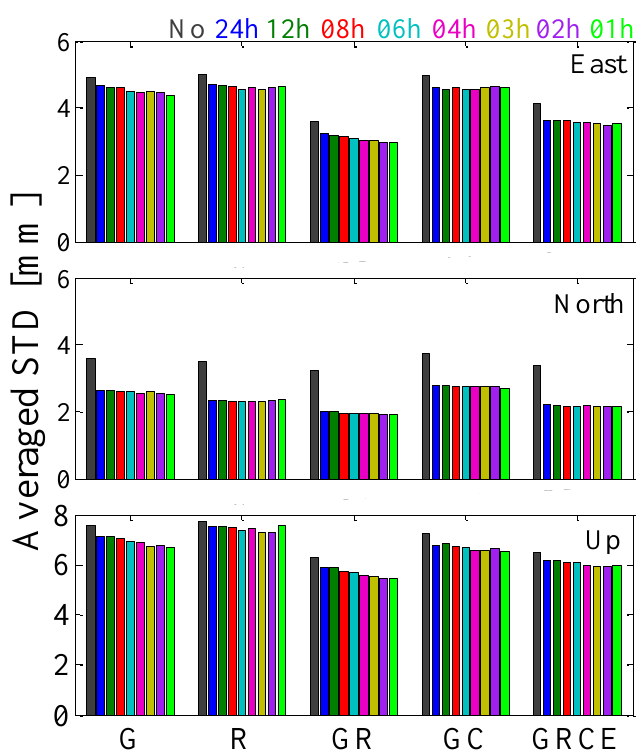
Figure 5. The averaged positioning repeatability of the selected 61 stations for GPS-, GLONASS-only, GPS + GLONASS, GPS + BDS and GPS + GLONASS + BDS + Galileo PPP solutions.